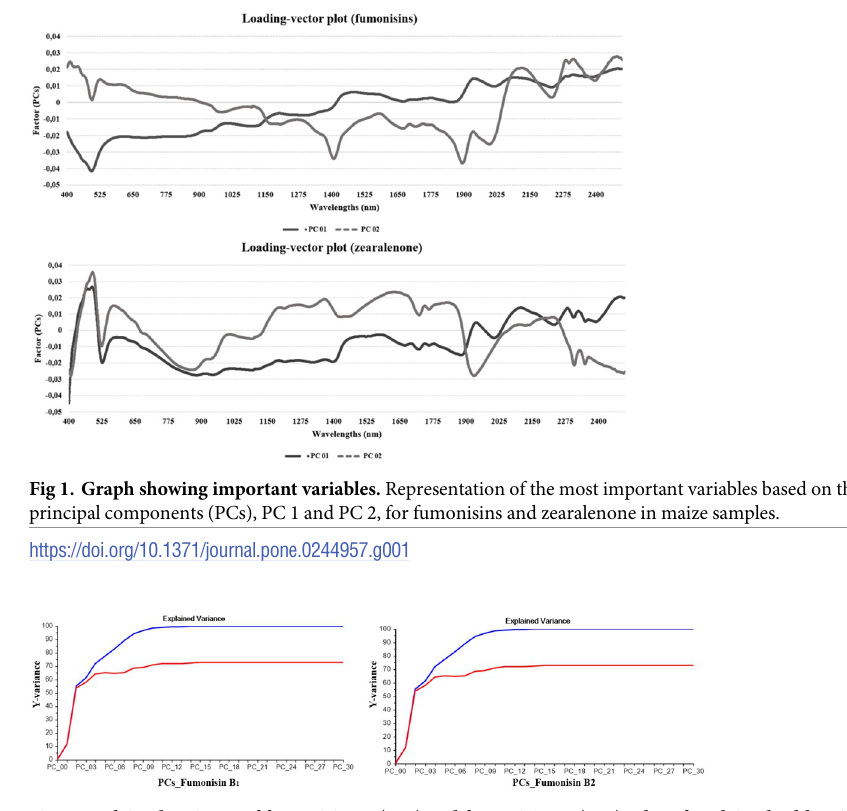
Fig 2. Explained variance of fumonisin B 1 (FB 1 ) and fumonisin B 2 (FB 2 ): Plot of explained calibration and validation variance versus number of Principal Components (PCs) for FB 1 and FB 2